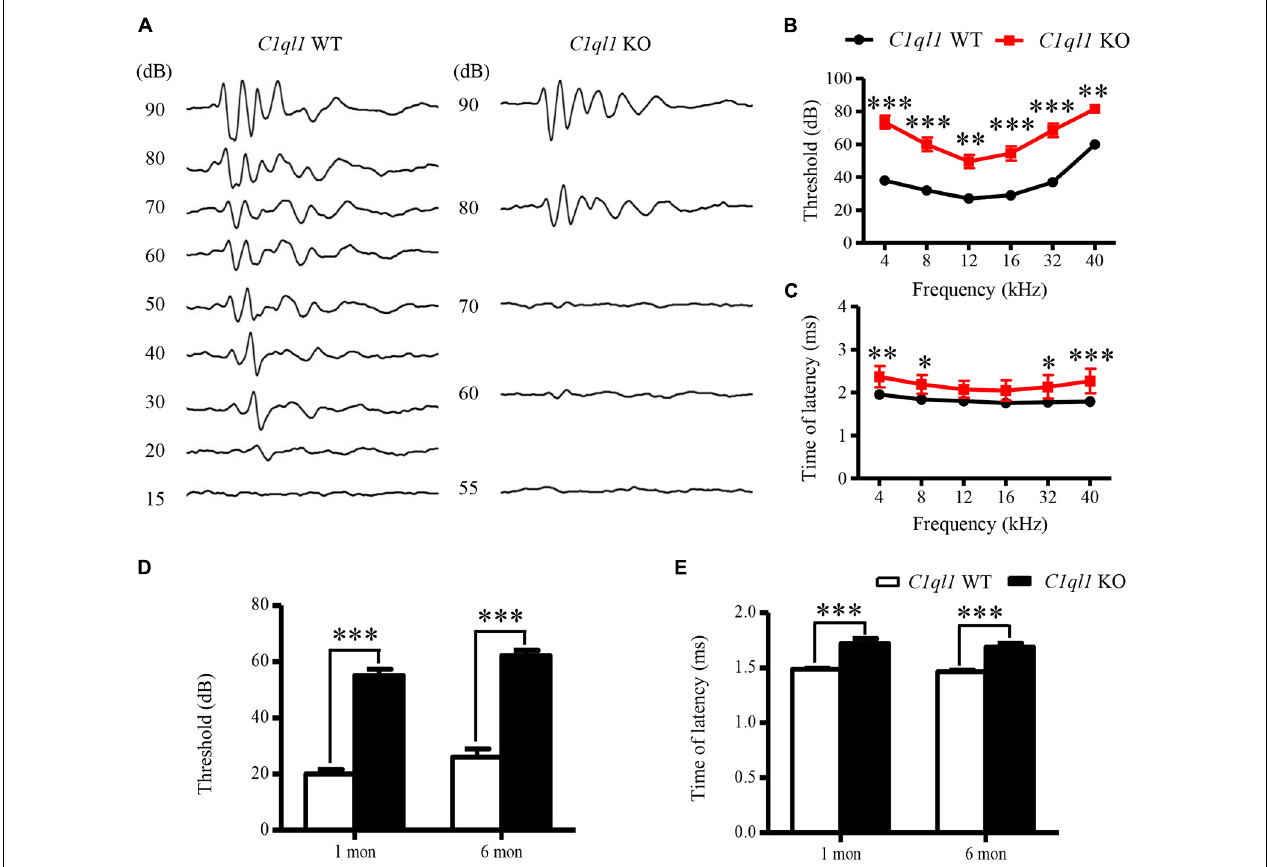
FIGURE 2 | Changes of ABR in C1ql1 KO mice. (A) Representative waves of click ABR in C1ql1 WT mice and C1ql1 KO mice. (B) Changes in threshold of ABR between C1ql1 KO mice and C1ql1 WT mice ( n = 5). (C) Changes in latency of ABR wave I between C1ql1 KO mice and C1ql1 WT mice. (D) Statistical differences in click ABR thresholds between C1ql1 KO mice and C1ql1 WT mice in postnatal 1 and 6 months ( n = 5). (E) Statistical differences in latency of click ABR wave I between C1ql1 KO mice and C1ql1 WT mice in postnatal 1 and 6 months ( n = 5). ∗ P < 0.05, ∗∗ P < 0.01, and ∗∗∗ P <